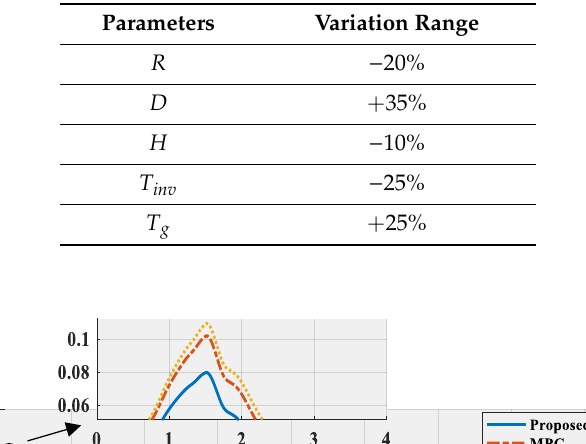
Table 2. Uncertain parameters of the test MG.